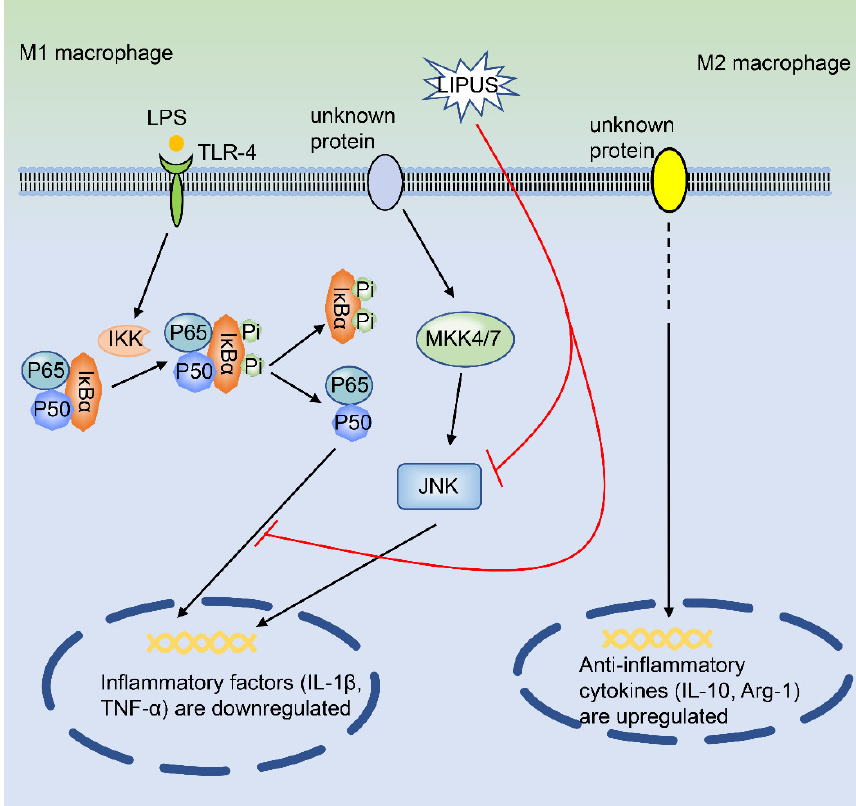
Figure 1. LIPUS regulates the polarization of macrophages. LIPUS significantly inhibits the LPS-induced activation of p-JNK and p-p65 in macrophages. At the same time, LIPUS down-regulates the expression of IL-1β and TNF-α mRNA, whereas it up-regulates the expression of IL-10 and Arg-1, in macrophages. LIPUS, low-intensity pulsed ultrasound; IL-1β, interleukin-1β; IL-10, interleukin-10; Arg-1, arginase-1; TNF-α, tumor necrosis factor-α; JNK, c-Jun N-terminal kinase; NF-κB, nuclear factor kappa-light-chain-enhancer of activated B cells; LPS, lipopolysaccharide.